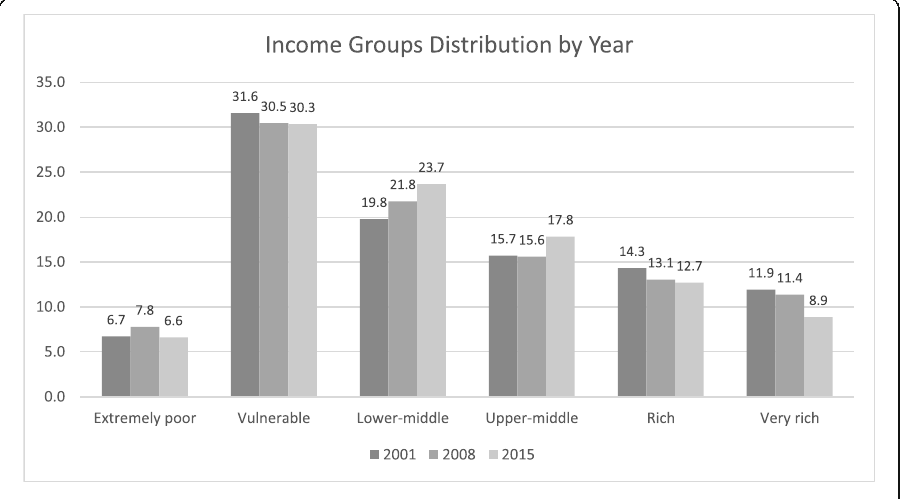
Fig. 1 Income group distribution in Brazil in 2001, 2008, and 2015. Data source: National Household Sample Survey, 2001, 2008, and 2015 —